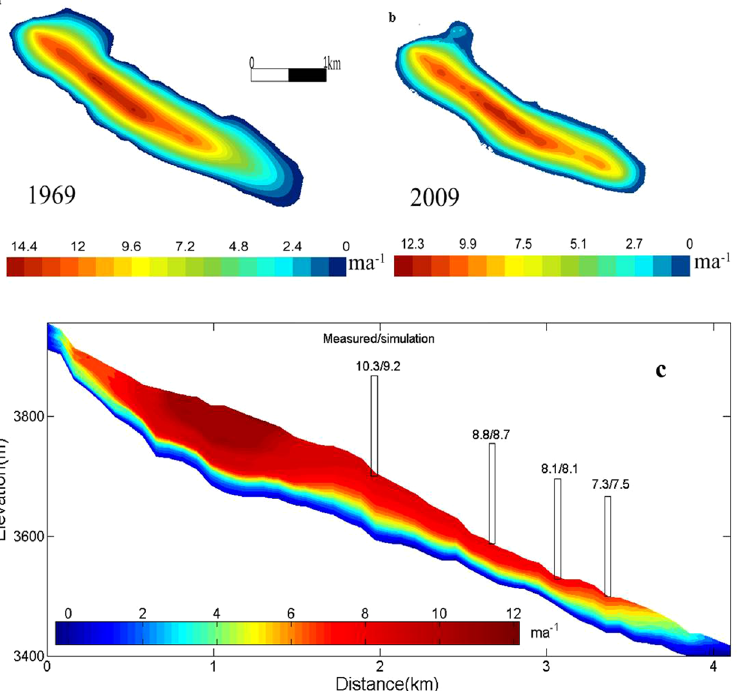
Figure 6. The simulated surface velocity. ( a ) The simulated surface velocity in 1969; ( b ) the simulated surface velocity in 2009; ( c ) the velocity distribution in the mainstream line in